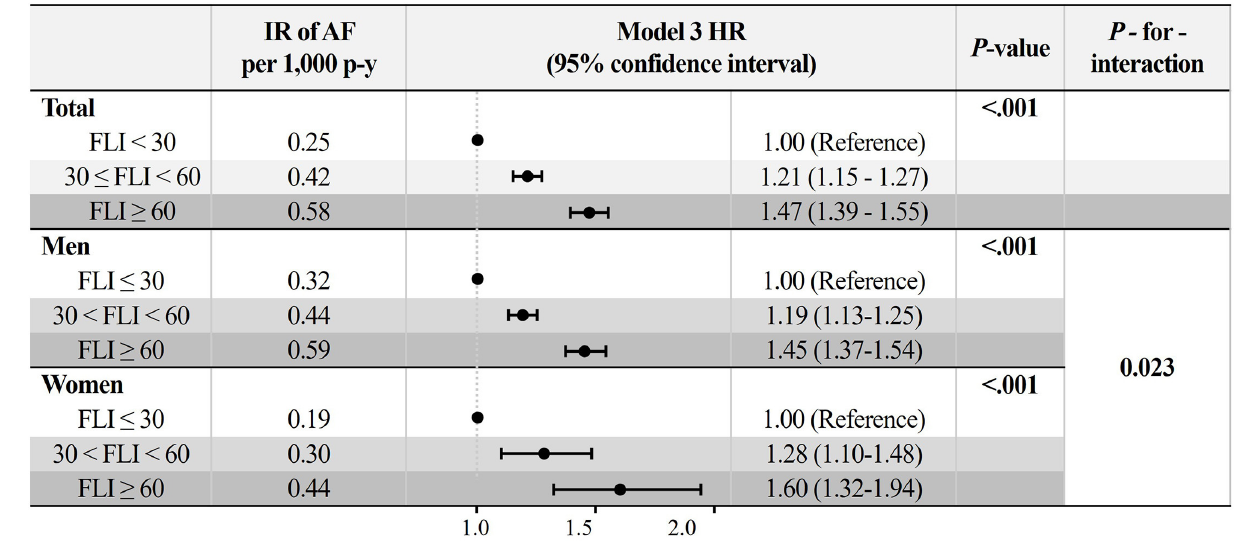
Frontiers in Cardiovascular Medicine |